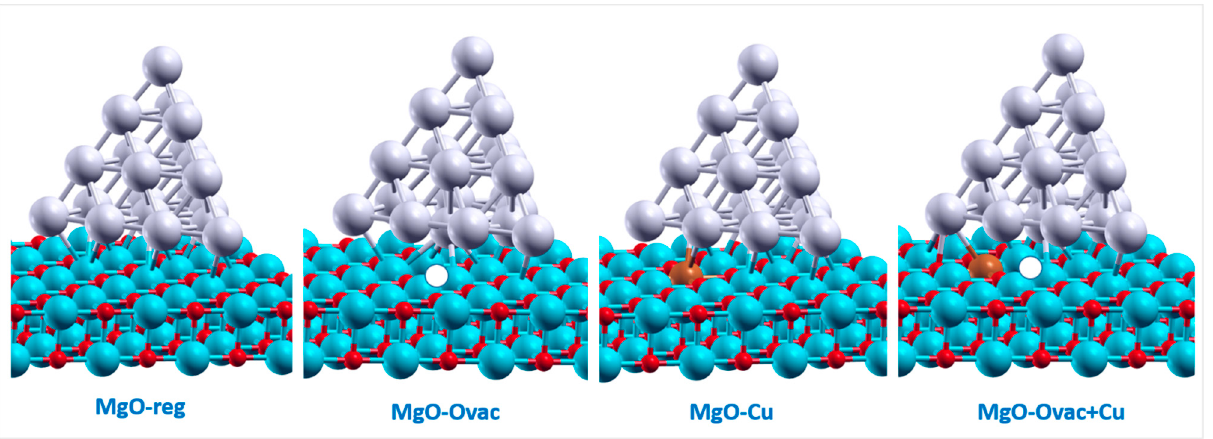
Figure 3. Representative geometries of some of the investigated systems—from left to right: Ag 20 /MgO(100)-reg, Ag 20 /MgO(100)-Ovac, Ag 20 /MgO(100)-Cu, and Ag 20 /MgO(100)-Ovac+Cu. Color coding: oxygen in red, magnesium in light blue, copper in brown, and oxygen vacancy represented with a white sphere.